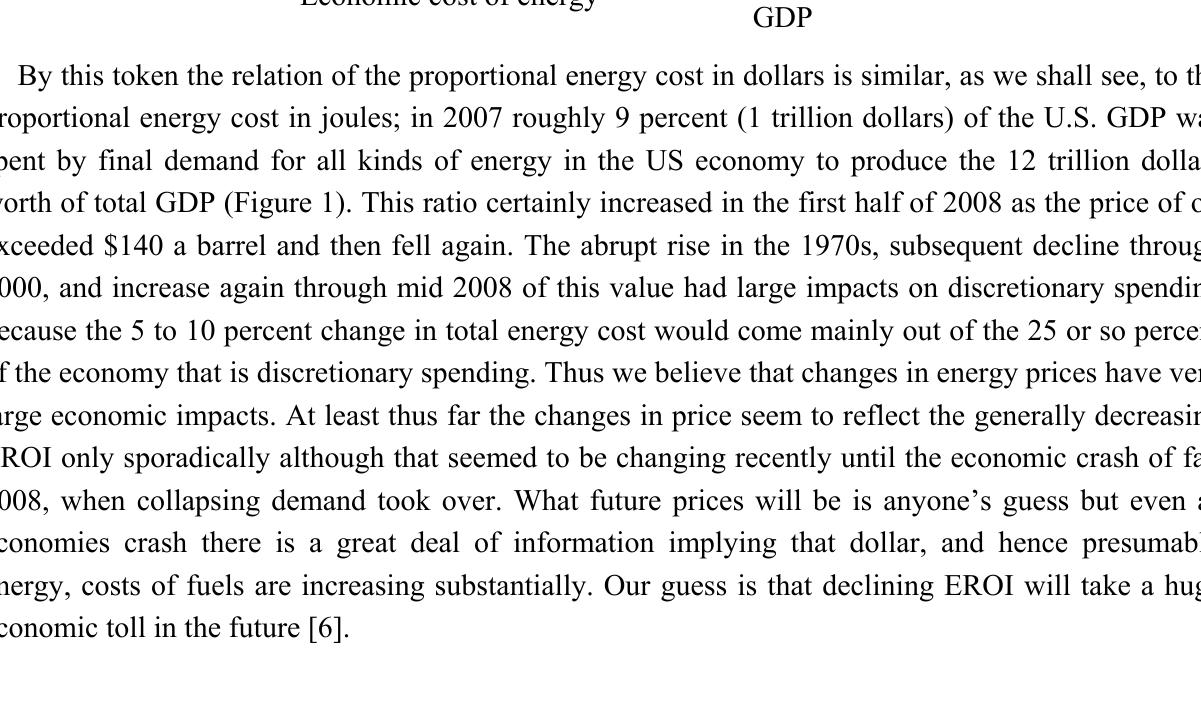
Figure 1. Percentage of GDP that is spent on energy by final consumers (2006-2008 estimated, source: